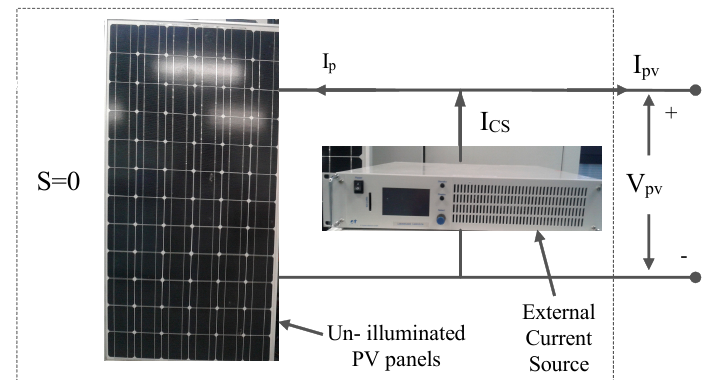
Figure 11. Circuit connection of the emulated PV source.